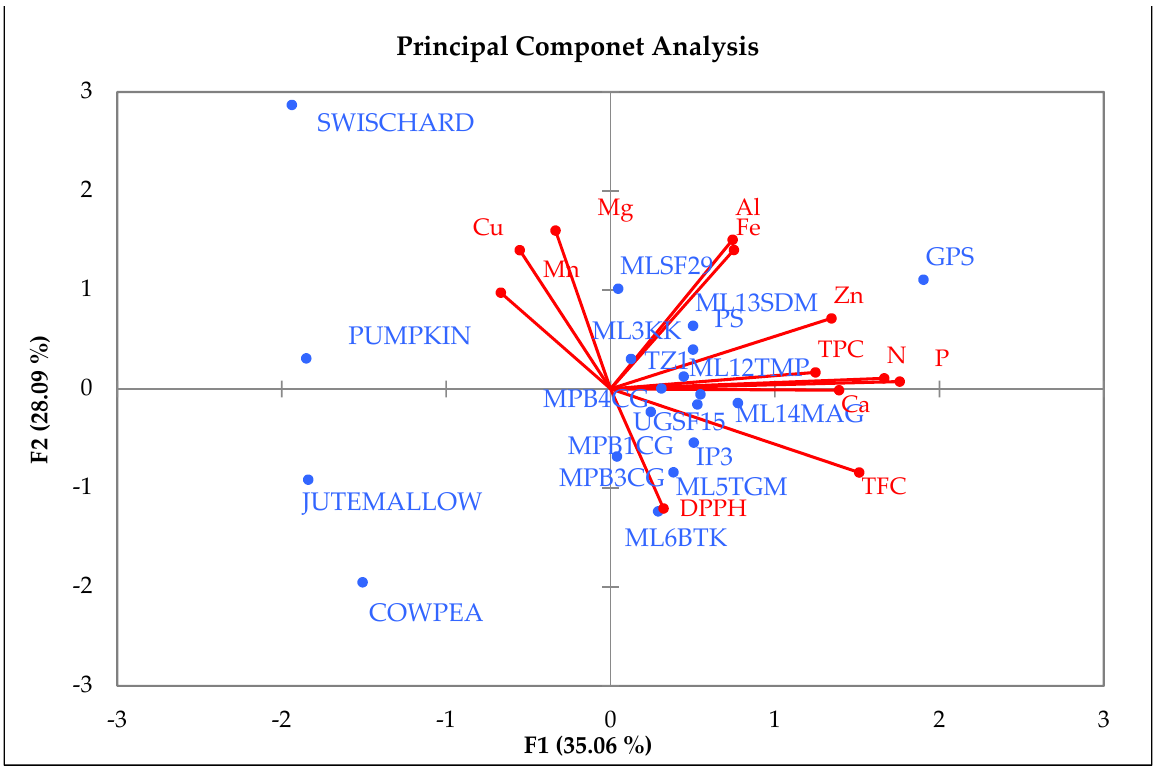
Figure 2. Principal component analysis of spider plant genotypes with mineral content, total polyphenol, and antioxidant activity.